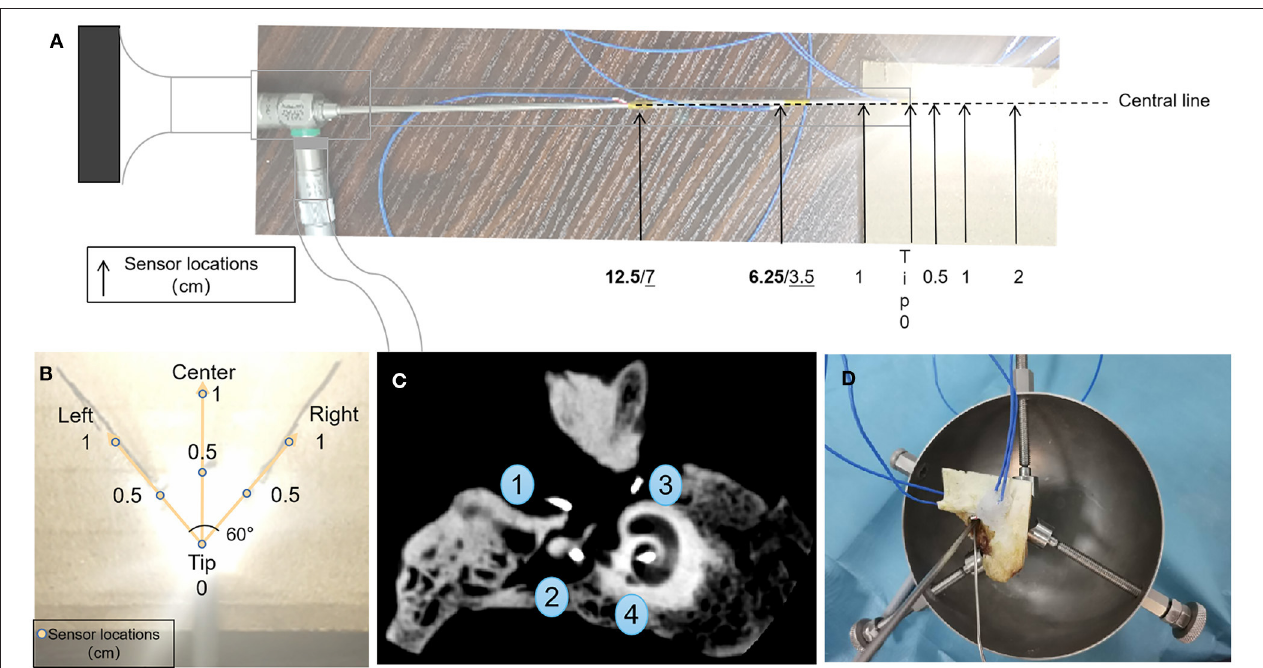
FIGURE 1 | Configurations for sensors in the open environment (A,B) and temporal bone (C) , and transcanal endoscopic ear surgery settings (D) . (A) Temperature sensors placement relating to the tip of the endoscope. Boldface indicates the 1/2 shaft length and 1/4 shaft length distances (cm) of the sensors to the rear of the tip of the neuroscope, and underline indicates their placement to the rear of the tip of the oto-endoscope. (B) Temperature sensors placement according to the illuminated area. (C) Representative cone-beam computed tomography images of sensor positions in temporal bone 4R. ‹ Fundus of the external auditory canal, › aditus ad antrum, fi round window/niche, and fl modiolus/fundus of the inner auditory canal.